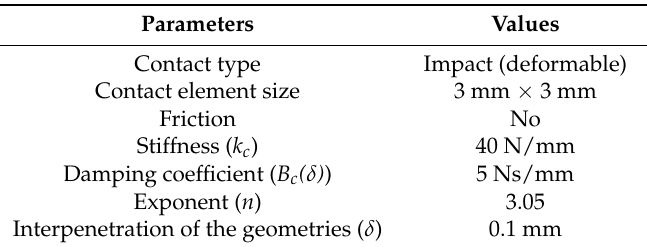
Table 1. Optimized contact parameter information.